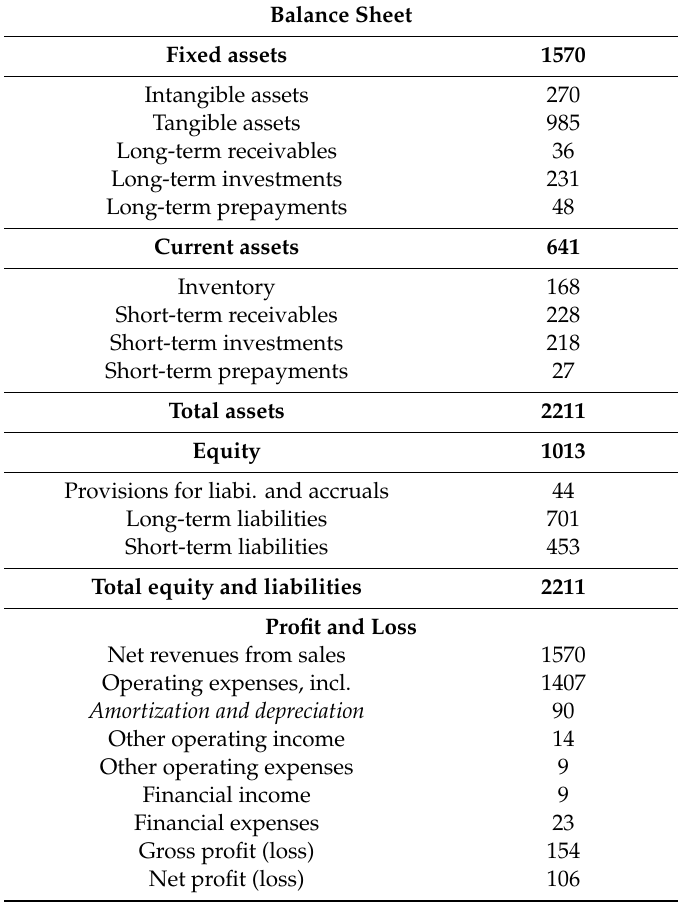
Table 1. Combined simplified balance sheet and profit and loss for the tested sample (in million EUR). Balance